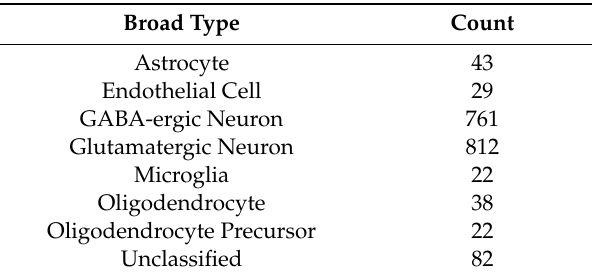
Table 1. Cell type and number of mouse visual cortex